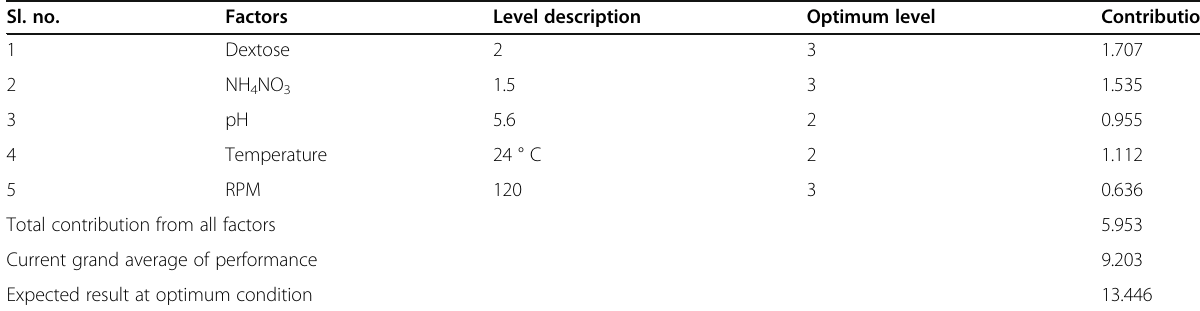
Table 4 Different factors at their best levels and their respective contributions Sl.